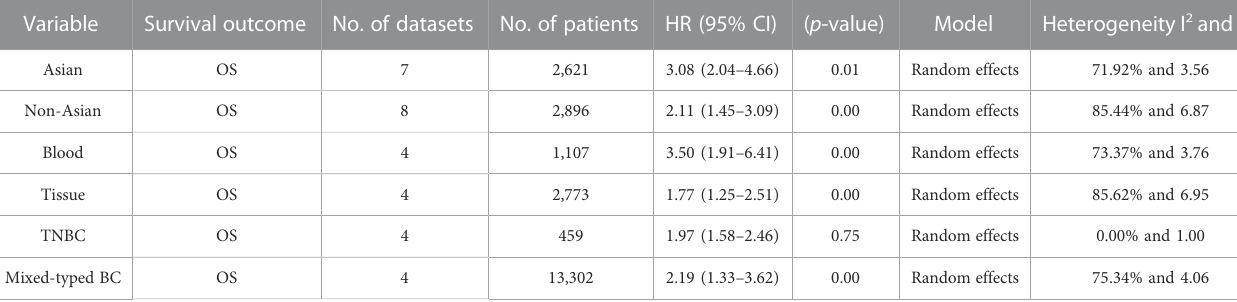
TABLE 2 Association of ncRNA expression with the survival rate based on different variables. Variable